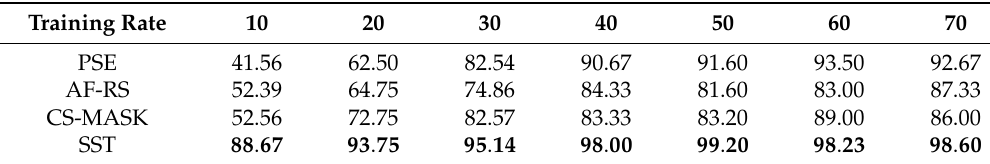
Table 4. Recognition rate for DatasetIII.